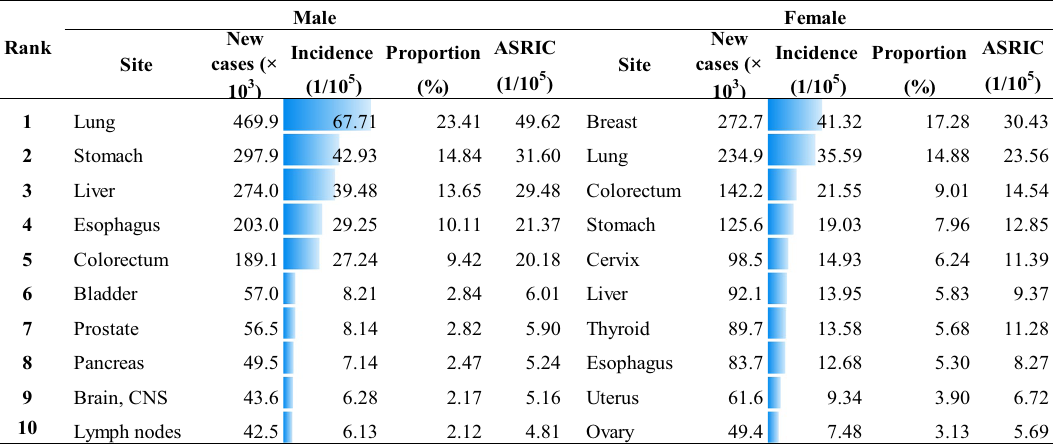
Table 3 Top ten cancer incidences in China in 2012 (This table is modified from a previous publication with permission, see Ref.